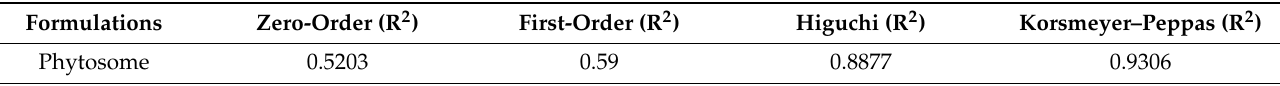
Table 4. Correlation coefficients for different kinetic